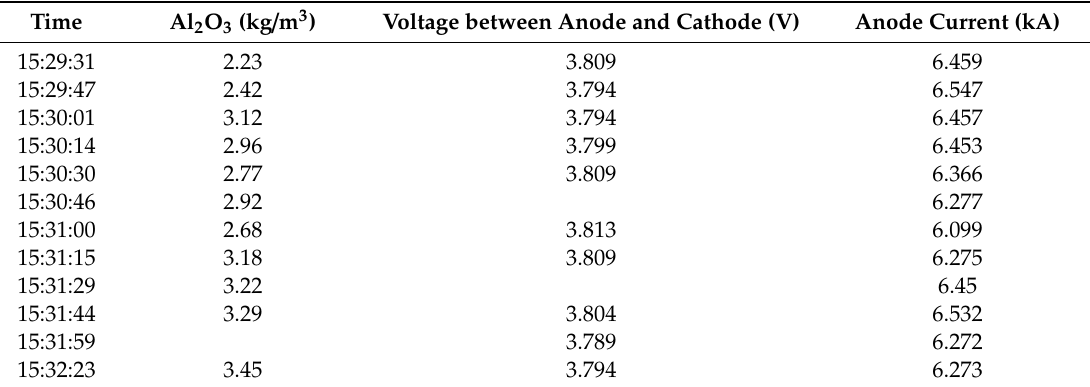
Table 1. Missing data.